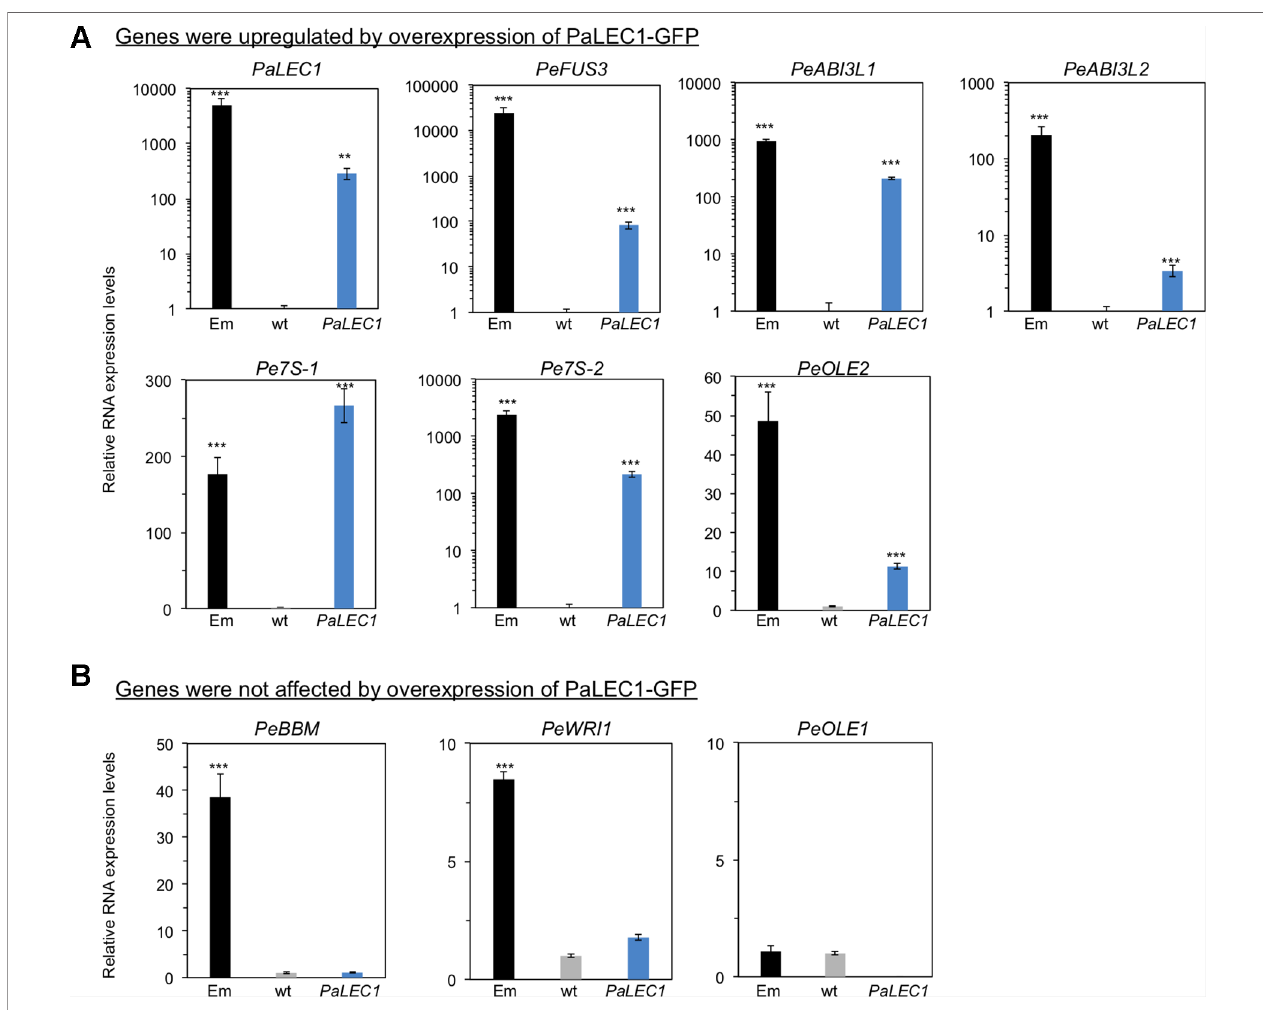
FIGURE 6 | Expression of embryonic genes in 35:PaLEC1-GFP#1 transgenic plants. (A) Expression of indicated embryonic genes was induced in 35:PaLEC1- GFP#1 transgenic plants. (B) Expression of indicated embryonic genes was not induced signi fi cantly by overexpression of PaLEC1-GFP protein. Em, zygotic embryonic tissues collected at 130 day after pollination. wt, wild-type plant. PaLEC1 , 35:PaLEC1-GFP#1 transgenic plants. ***, P < 0.001; **, P < 0.01. Three independent biological replicates were